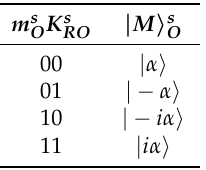
Table 1. The corresponding relations between m s